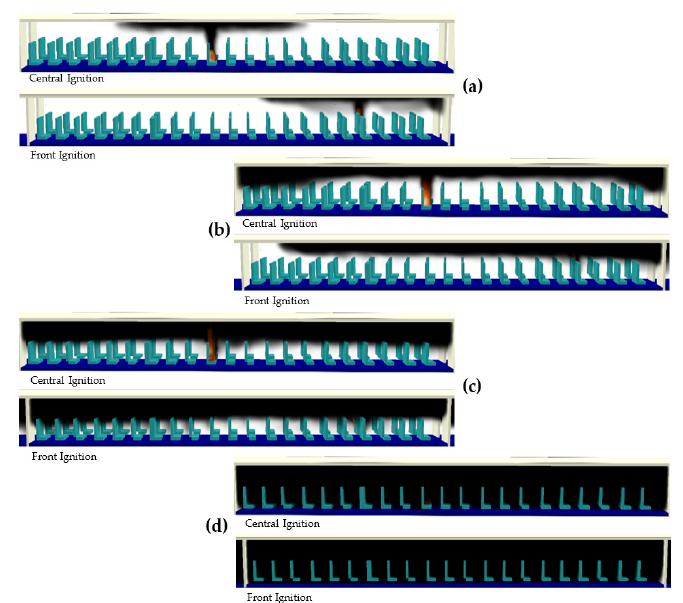
Figure 4. Smoke distribution due to varying ignition position after ( a ) 10 s; ( b ) 30 s; ( c ) 50 s; ( d ) 100 s.